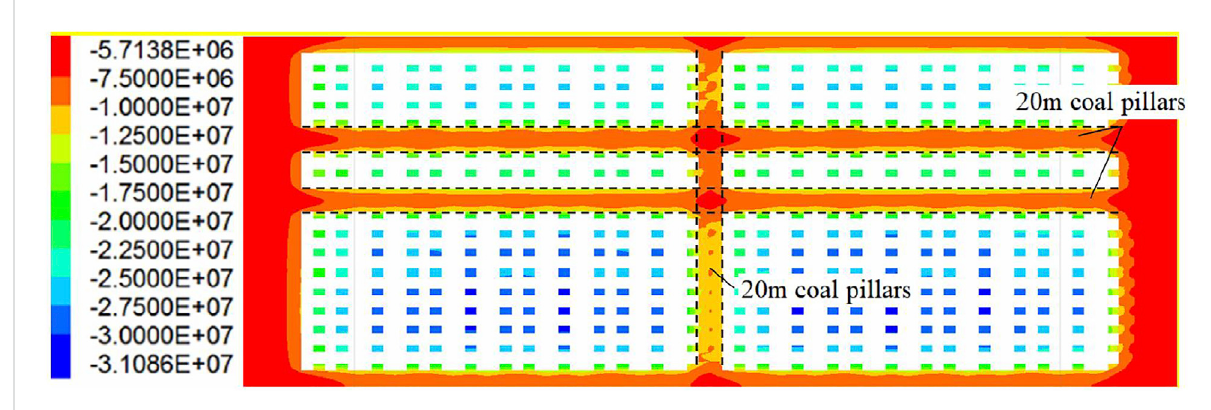
FIGURE 11 Vertical stress distribution of strata at 8m on top of 3# coal seam (Pa).